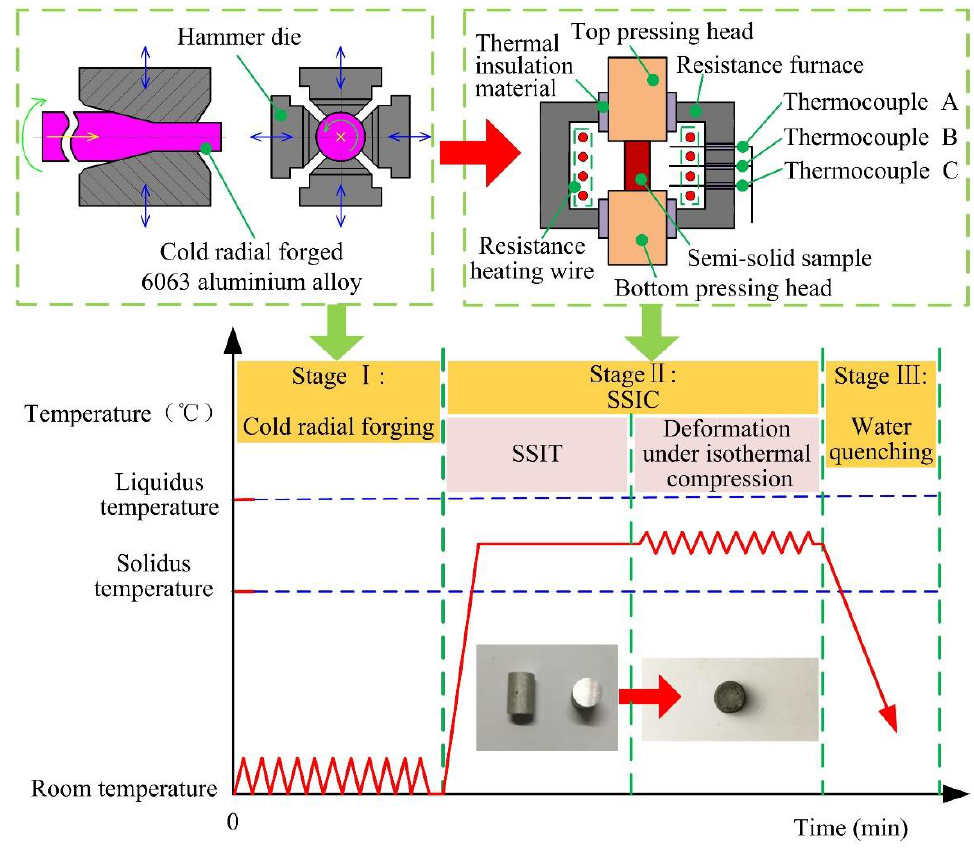
Figure 1. Schematic illustration of the SSIC process of the cold radial forged 6063 aluminium alloy. Table 2. Experimental process